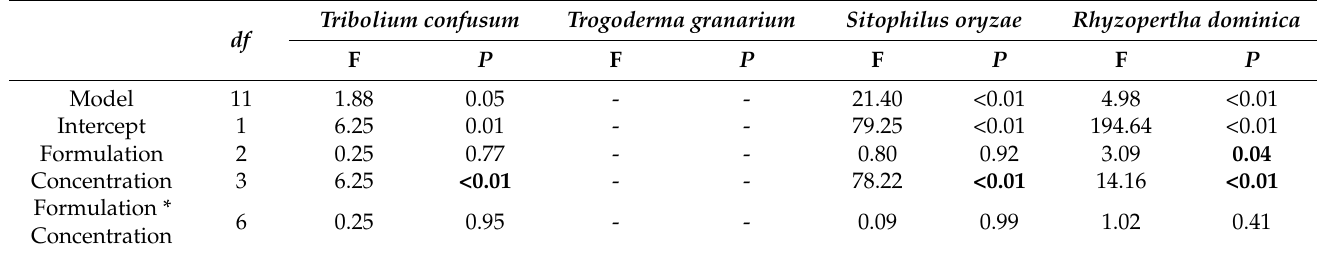
Table 7. ANOVA parameters for progeny production counts for each species exposed to three different dust formulations (D1, D2, and W) and four concentration rates (500, 1000, 2000 ppm, and control).